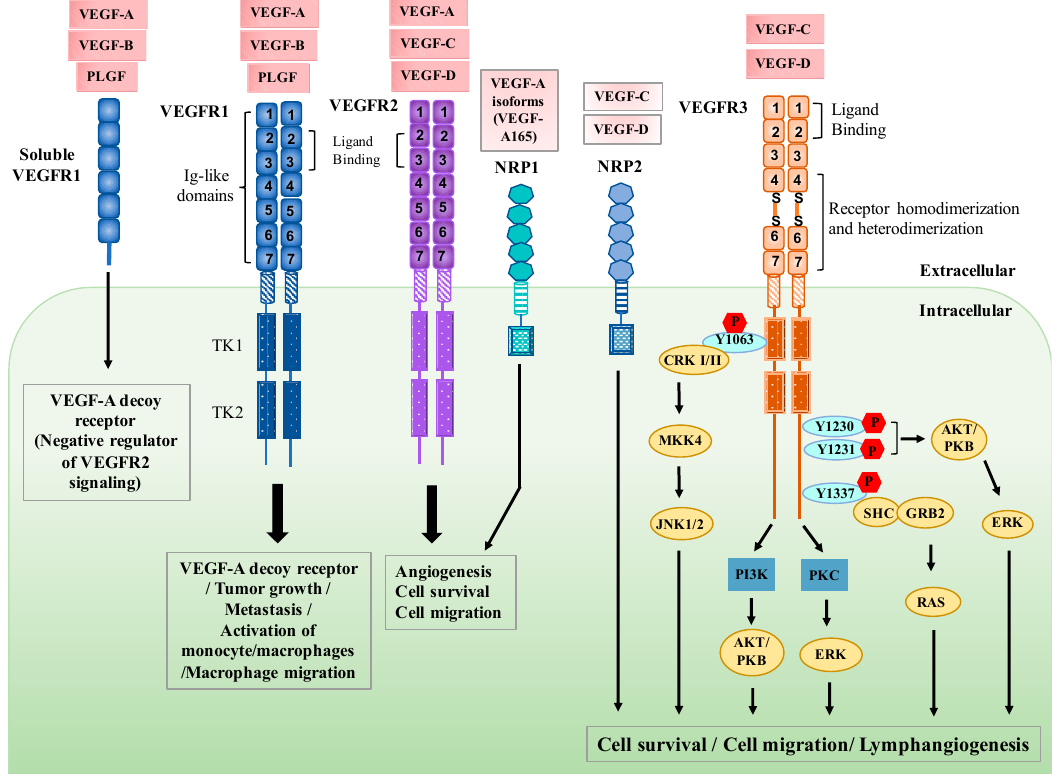
Figure 1. The signaling pathways of vascular endothelial growth factors and vascular endothelial growth factor receptors (VEGFs/VEGFRs) and their biological functions. The three tyrosine kinase (TK) receptors have specific binding capabilities. VEGF-A, VEGF-B, and PLGF can bind to VEGFR1 and mediate its biological functions. The binding of VEGF-A, VEGFR-C, and VEGF-D can stimulate the activation of VEGFR2, resulting in cell proliferation and angiogenesis. VEGF-C and VEGF-D bind to VEGFR3 and induce downstream signaling which mediates cell survival and lymphangiogenesis. Neuropilin 1 (NRP1) and neuropilin 2 (NRP2) can function as co-receptors for VEGFR2 and VEGFR3. The binding of VEGF-A isoforms and NRP1 can form a complex with VEGFR2, leading to the induction of downstream signaling which regulates the proliferation and migration of endothelial cells. VEGF-C/D bind to NRP2 and forms a complex with VEGFR3, activating the VEGFR3 signaling which enhances the proliferation of lymphatic endothelial cells (LECs) and lymphangiogenesis. MKK4, Mitogen-activated protein kinase kinase-4; JNK1/2, c-Jun N-terminal kinase-1/2; PI3K, phosphoinositide-3 kinase; AKT/PKB, AKT/protein kinase B; PKC, protein kinase C; ERK, extracellular signal–related kinase; SHC-GRB2, Src homology domain containing growth factor receptor–bound protein 2.